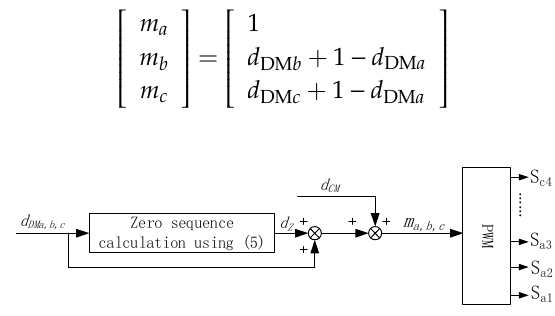
Figure 12. d CM implementation in CPWM application [14].